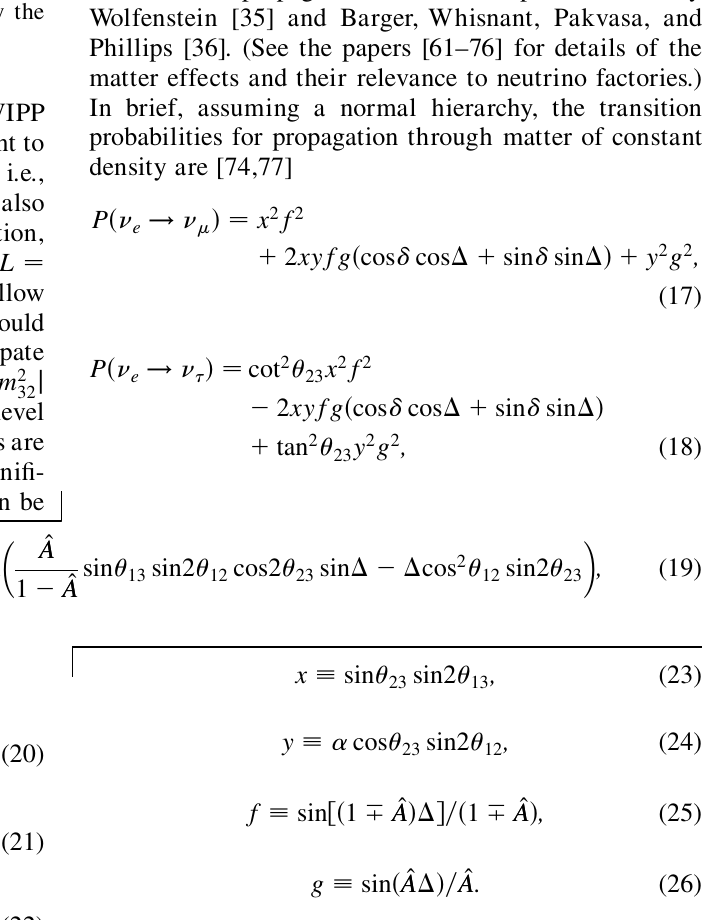
FIG. 3. Fit to muon neutrino survival distribution for E 30 GeV and L (cid:4) 2800 km for ten pairs of sin 2 2 (cid:5) , (cid:6)m 2 values. For each fit, the 1 (cid:31) , 2 (cid:31) , and 3 (cid:31) contours are shown. The generated points are indicated by the dark rectangles and the fitted values by stars. The SuperK 68%, 90%, and 99% con- fidence levels are superimposed. Each point is labeled by the predicted number of signal events for that